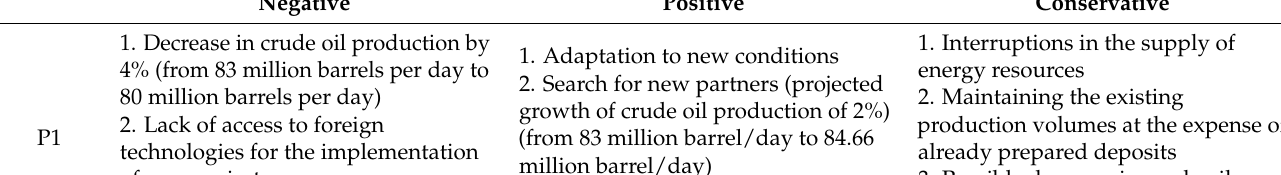
Table 4. Forecasted states of fossil energy with the account of the influence of risks [45,52–55,61,67]. Negative Positive